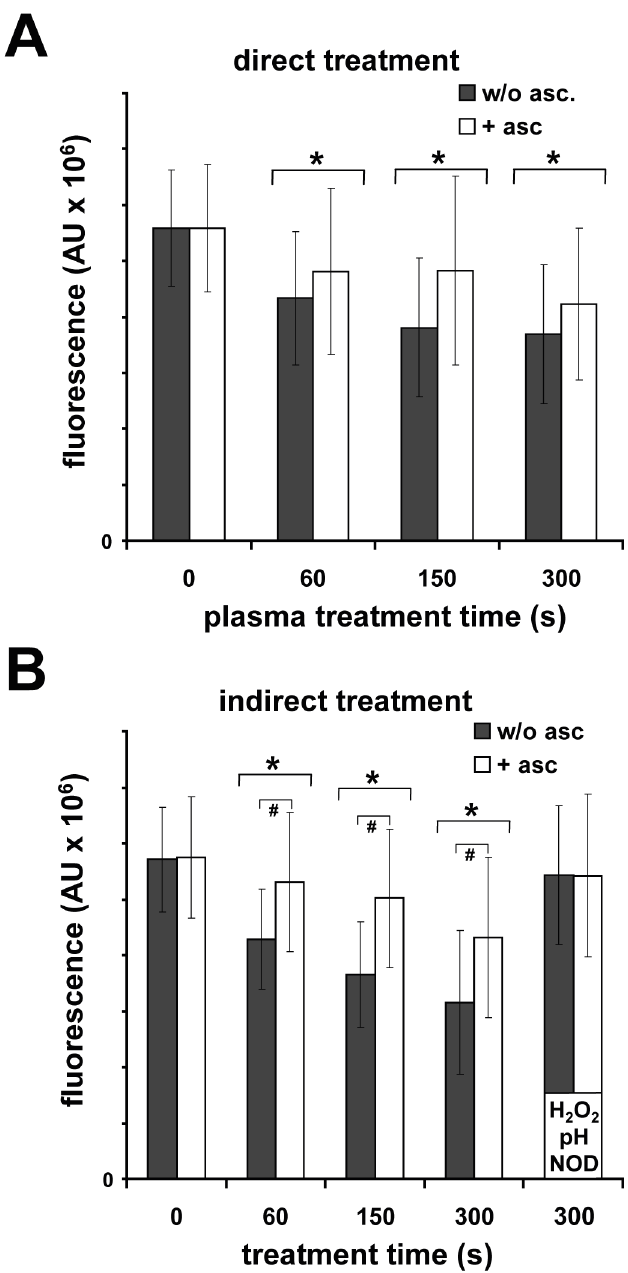
Fig 2. DBD treatment reduces fibroblast viability. A Human dermal fibroblasts were treated with DBD (0 – 300 s) ± ascorbate ( asc ; 1.0 mM) and cell viability was measured 24 h later by a resazurin-based assay. B Cells were exposed for 5 min to buffer ± ascorbate (1.0 mM), which had been DBD-treated (0 – 300 s) shortly before or exposed to a freshly prepared buffer with a pH of 6.7 ( pH ) containing hydrogen peroxide (200 μ M; H2O2), nitrite and nitrate ( NOD ; 300 μ M, 1.0 mM). Given are mean ± sd values (n = 5), * P < 0.05 as compared with the control values,# P < 0.05 as compared to respective values without